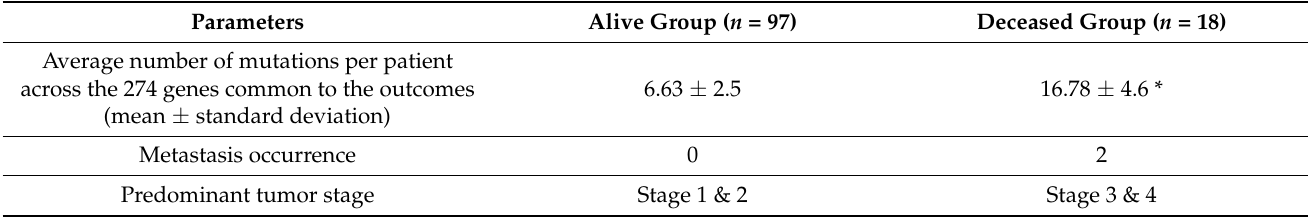
Table 3. Correlating information on differentially expressed somatic mutated genes common to both patient groups with clinical information.